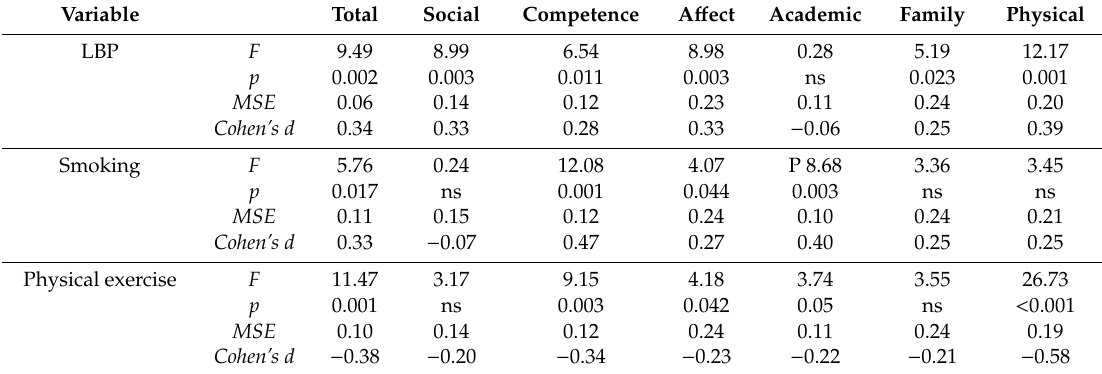
Table 4. Results of single ANOVAs from